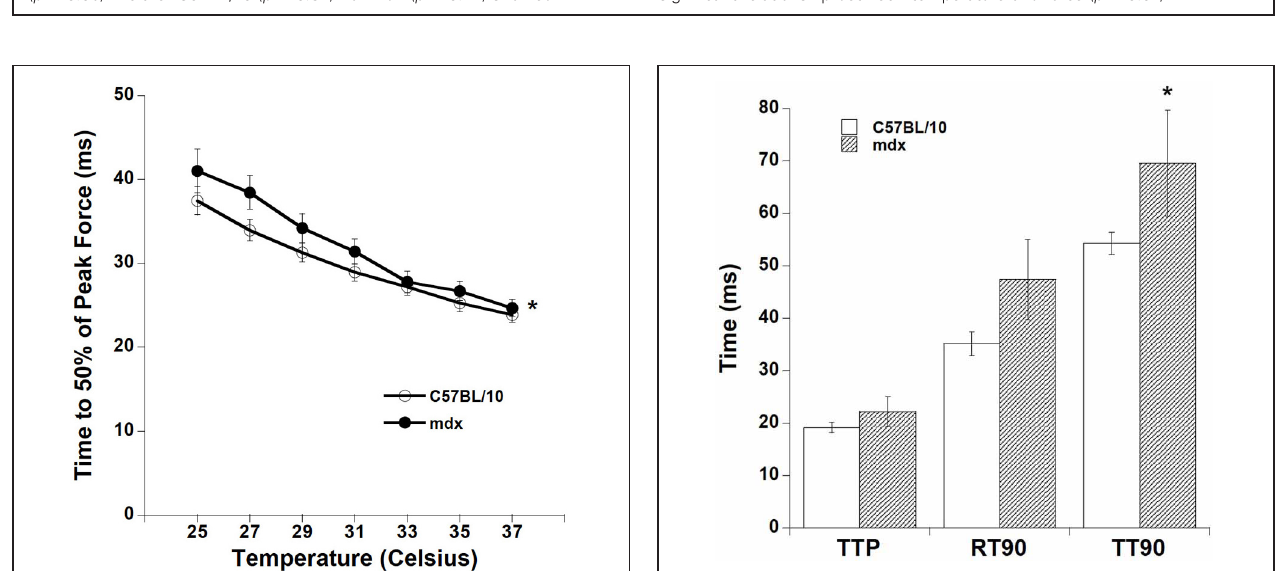
FIGURE 3 | (A) Warming/cooling force comparisons for C57BL/10 and mdx diaphragm strips. Force increased significantly with temperature for the C57BL/10 group ( p = 0 . 01) but not quite significantly in the mdx group ( p = 0 . 06). Neither C57BL/10 ( p = 0 . 84) nor mdx ( p = 0 . 24) showed